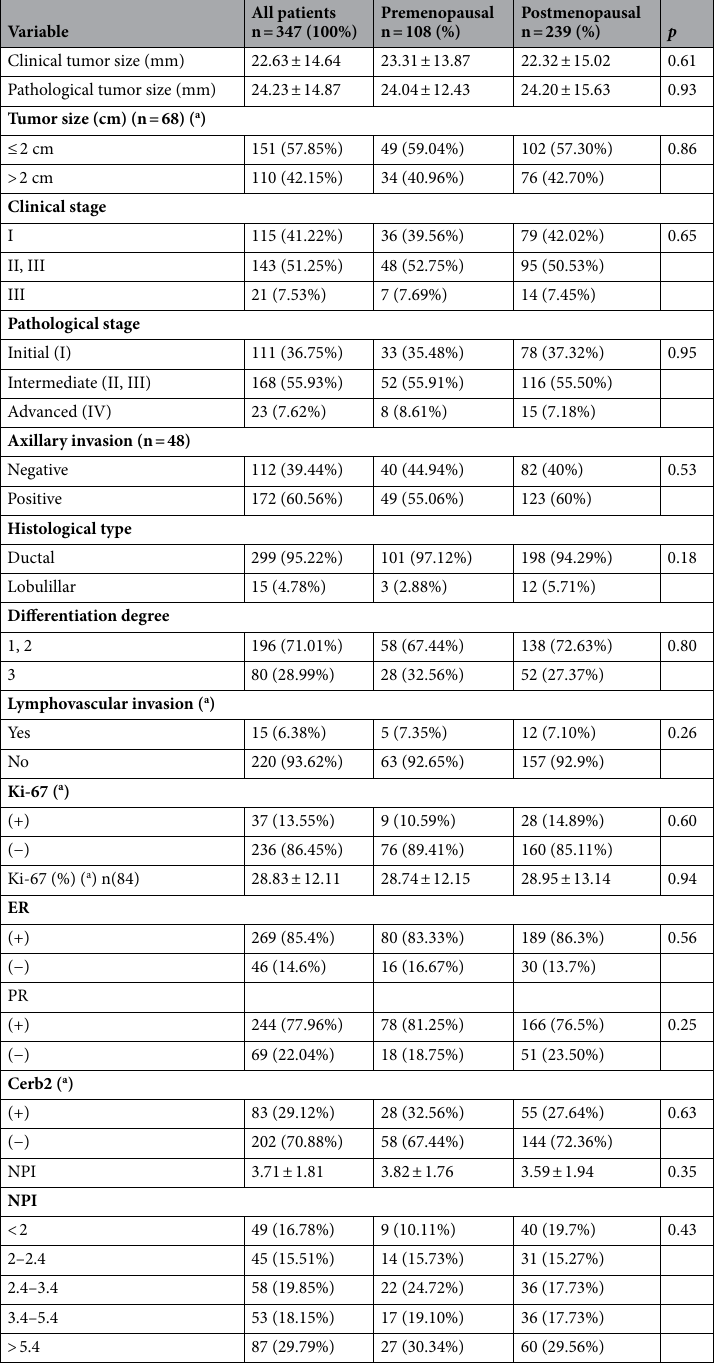
Table 7. Prognostic tumor characteristics in patients according to their hormonal status (pre vs. postmenopausal). Data expressed as means ± standard deviation and absolute numbers and their frequencies. NPI Nottingham prognostic index. * p value < 0.05 (t-Student or Chi-squared). a Analysis performed on the cases provided by the pathology